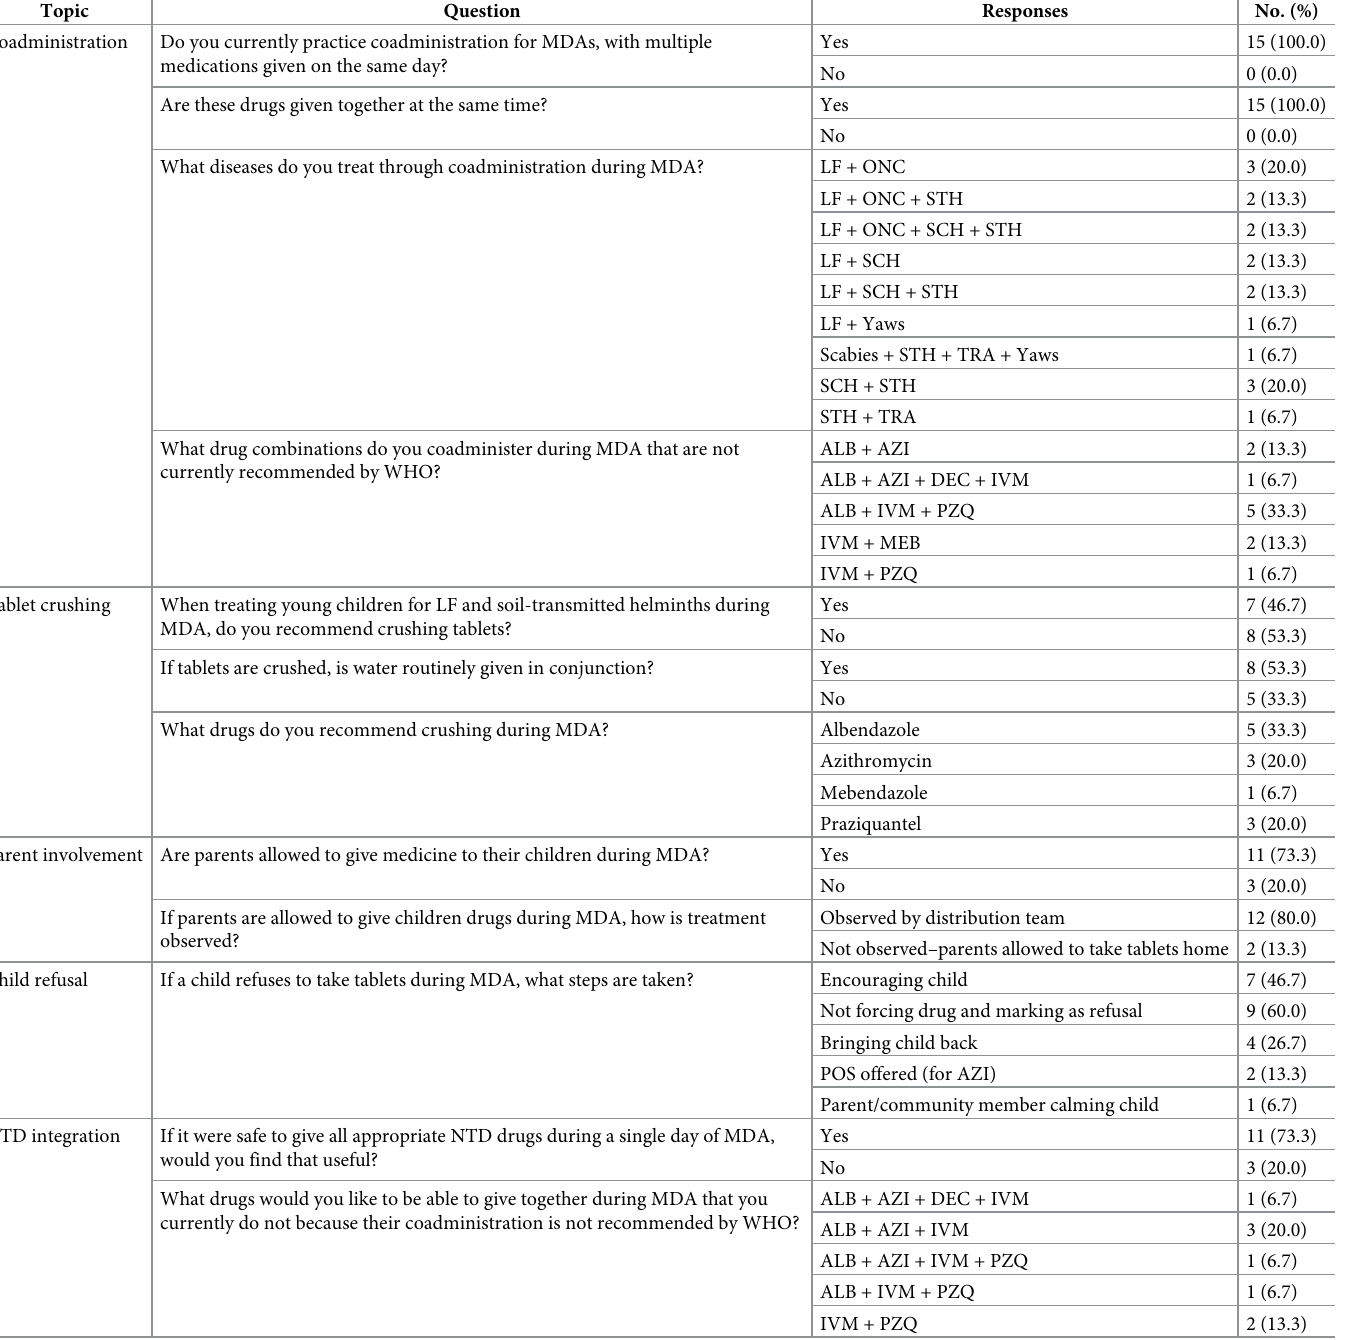
Table 4. Common thematic elements of MDA integration surveys. Topic Question Responses No.